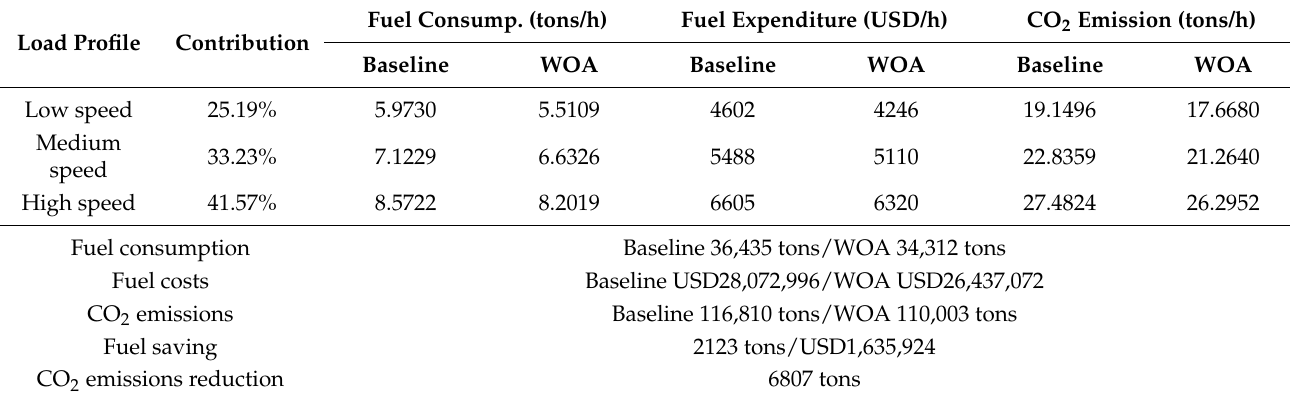
Table 3. Average fuel-saving results of all algorithms.